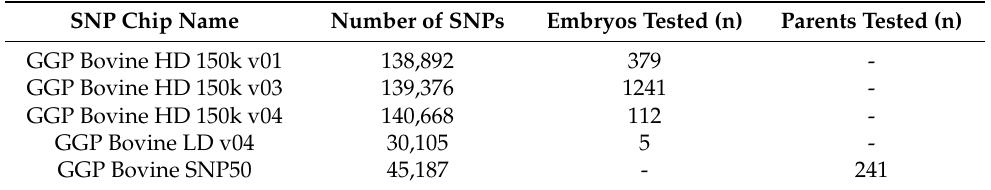
Table 1. SNP chips employed in this study. All chips were manufactured by Illumina (as part of their bovine